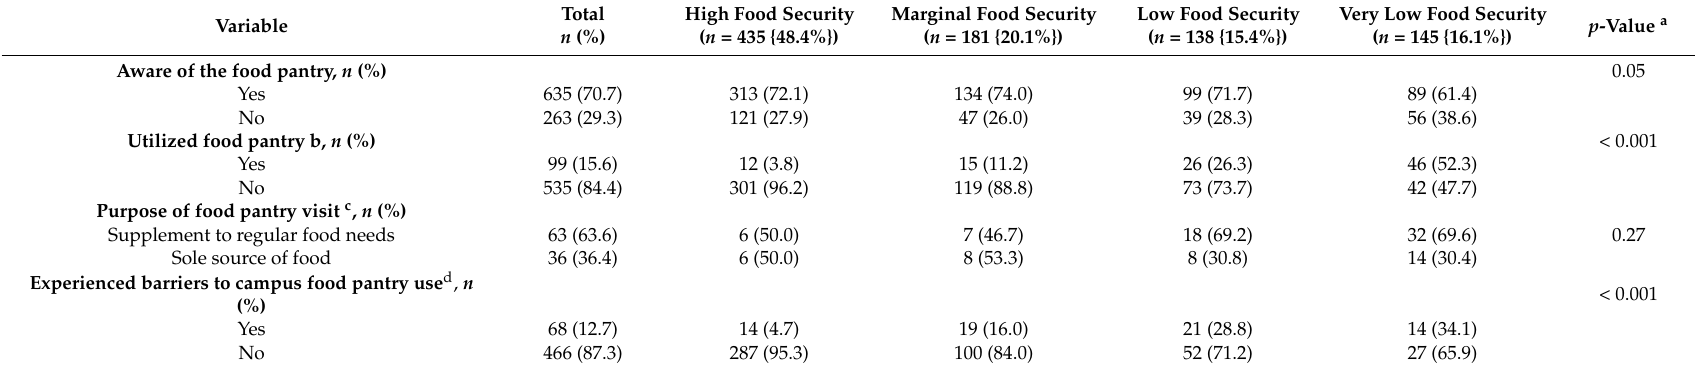
Table 2. Prevalence of awareness, use, and barriers to use of the campus food pantry by food security status among college students in the United States,